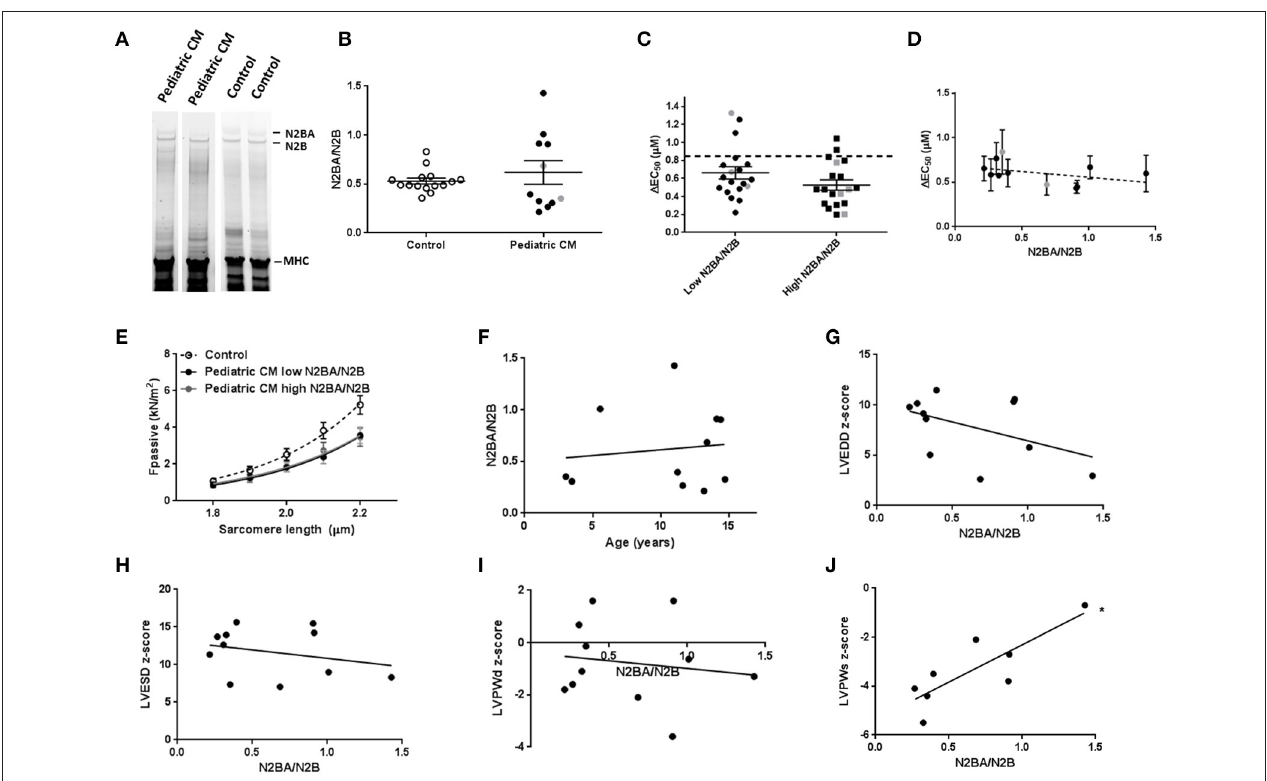
FIGURE 2 | Titin isoform composition has limited effect on contractility in pediatric CM. (A) Separation of titin N2BA and N2B with gel electrophoresis. (B) N2BA/N2B ratio was not significantly different between pediatric CM (0.62 ± 0.12, N = 11) and controls (0.53 ± 0.03, N = 15). (C) Length-dependent activation was mostly impaired in pediatric CM patients who had higher N2BA/N2B ratio (N2BA/N2B > 0.65, N = 5, n = 19) compared to pediatric CM patients who had lower N2BA/N2B ratio (N2BA/N2B < 0.4, N = 6, n = 19). Dotted line indicates control values. (D) Mean 1 EC 50 per sample plotted against the N2BA/N2B ratio did not show a significant correlation between 1 EC 50 and N2BA/N2B. (E) There was no difference in F pass between pediatric CM patients who had higher N2BA/N2B ratio (N2BA/N2B > 0.65, N = 5, n = 18) and pediatric CM patients who had lower N2BA/N2B ratio (N2BA/N2B < 0.4, N = 6, n = 22). (F) N2BA/N2B ratio was not significantly related to age. (G) No significant correlation was found between N2BA/N2B and LVEDD z-score. (H) No significant correlation was found between N2BA/N2B and LVESD z-score. (I) No significant correlation was found between N2BA/N2B and LVPWd z-score. (J) A significant correlation was found between N2BA/N2B ratio and LVPWs z-score ( p < 0.05). N , number of samples; n , number of cardiomyocytes measured. Measurements obtained from samples derived from patients with non-compaction cardiomyopathy are indicated in gray (B–D)